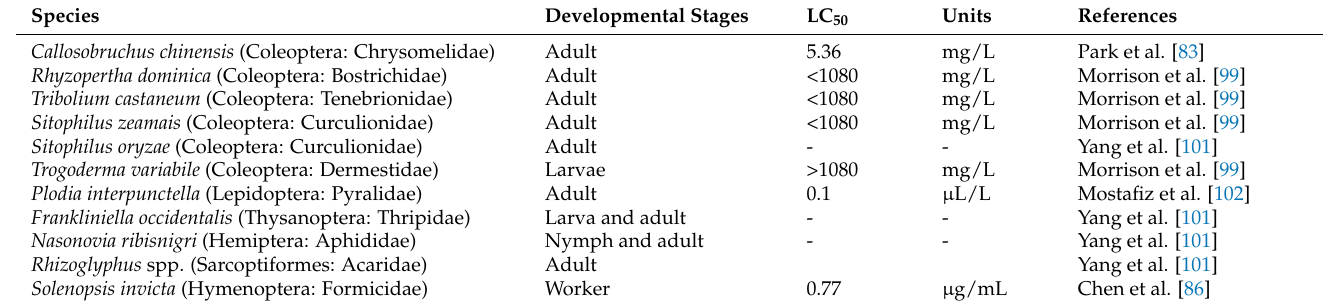
Table 2. Fumigation toxicity of methyl benzoate to different stored product pests with LC 50 values.